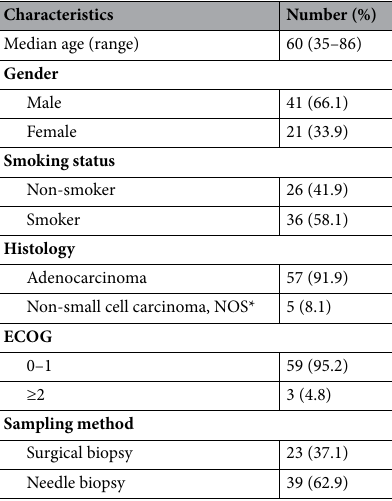
Table 1. Patient characteristics (n = 62). *NOS not otherwise specified.